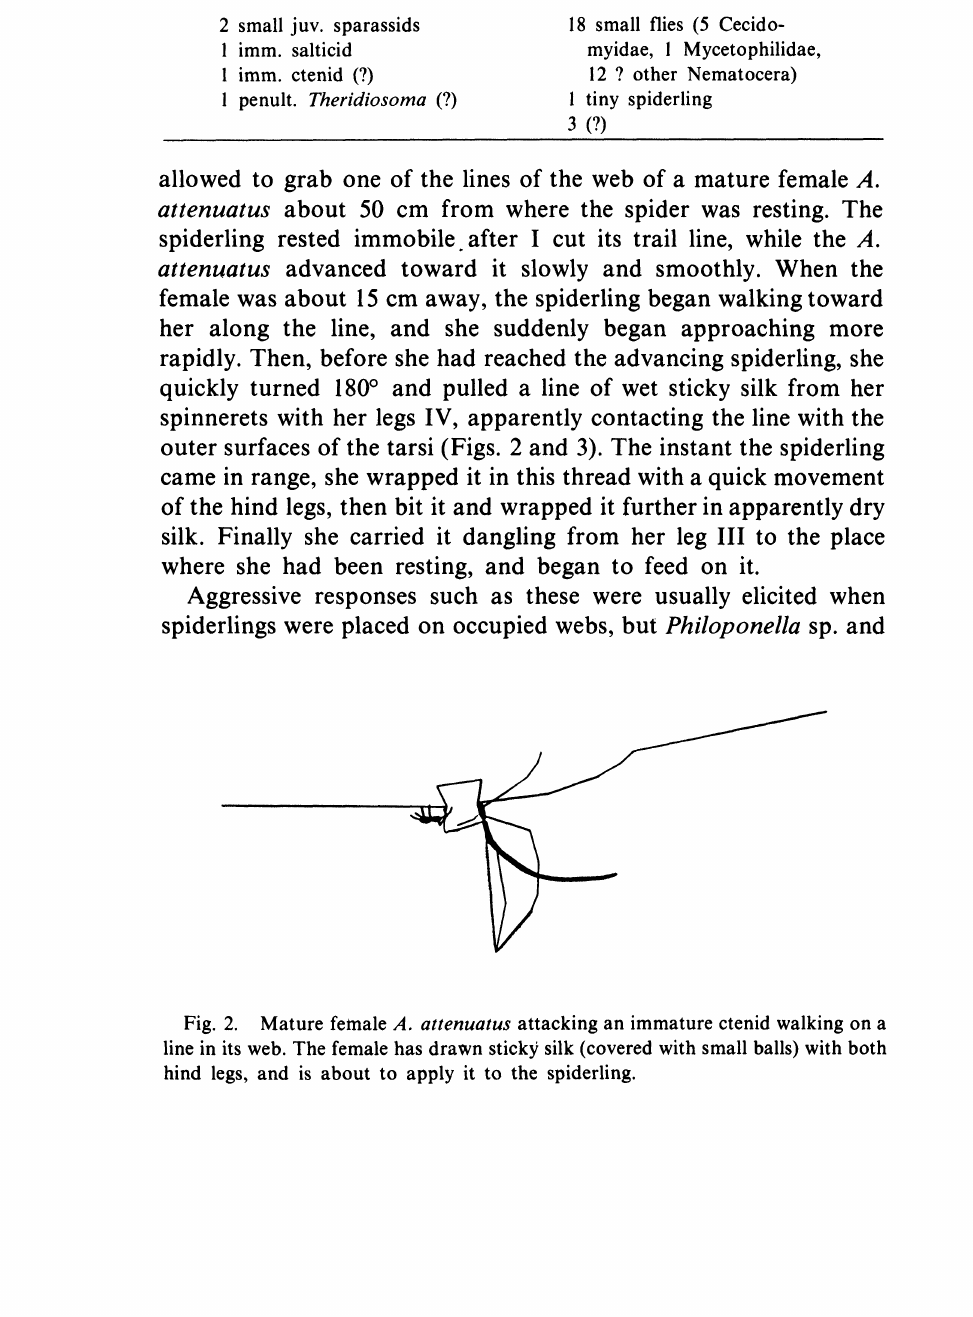
Psyche [December Prey found being fed on by Argyrodes attenuatus in the field. Mature and penultimate females spiderlings